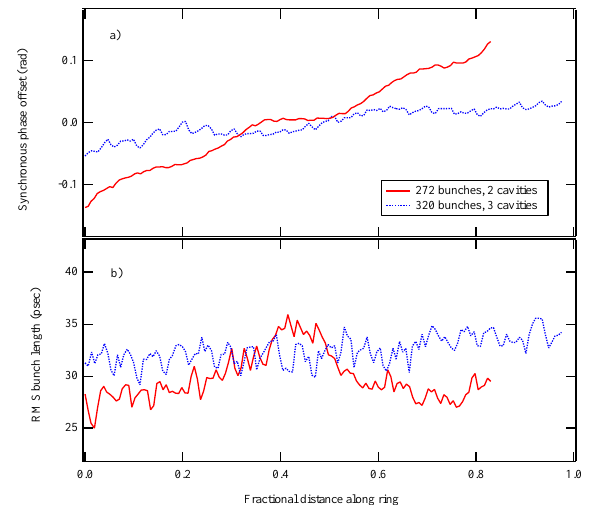
FIG. 1. (Color) Longitudinal beam offset and bunch length along the bunch train. The variation in synchronous phase due to transient loading of the cavities is much larger in the case of 272 bunches. The transient loading also results in a variation of the bunch length along the